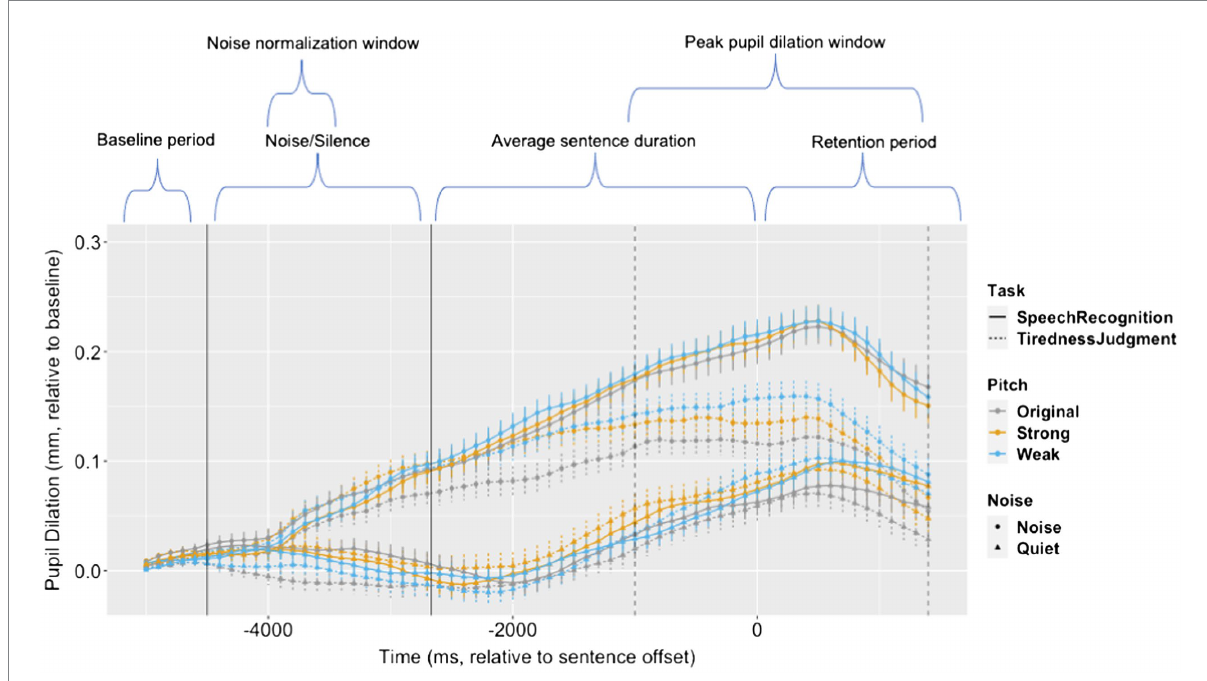
FIGURE 1 Pupil dilation relative to baseline during the time window of -5,000ms to +1,500ms relative to sentence offset. Error bars: ± standard error. The vertical dotted lines mark the onset and offset of the time window for peak pupil dilation measure. The vertical solid lines mark the onset of sound stimuli and the average onset of sentences. The labels above the graph indicate different events and analysis windows during the